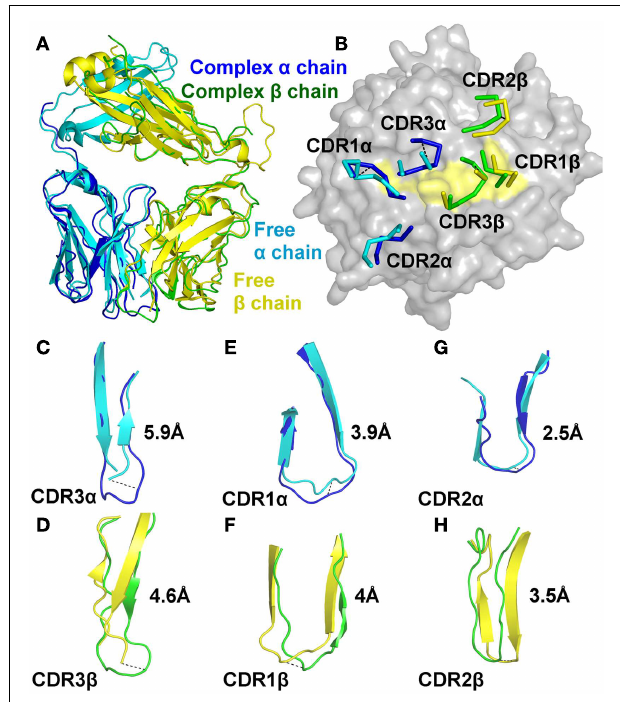
FIGURE 2 |TheA6c134TCR CDR loops undergo a large degree of conformational adjustment during binding toA2-Tax . Comparison of the conformations of the A6c134TCR CDR1, CDR2, and CDR3 loops in the A6c134/A2-Tax complex versus A6c134TCR free structures. (A) Superposition of the free (cyan and yellow cartoon) and complexed (blue and green cartoon) A6c134TCR. (B) Superposition of the free (cyan and yellow lines) and complexed (blue and green lines) A6c134TCR looking down on the A2-Tax surface (gray and yellow surface). (C) Superposition of the free (cyan cartoon) and complexed (blue cartoon) A6c134TCR CDR3 α loop. (D) Superposition of the free (yellow cartoon) and complexed (green cartoon) A6c134TCR CDR3 β loop. (E) Superposition of the free (cyan cartoon) and complexed (blue cartoon) A6c134TCR CDR1 α loop. (F) Superposition of the free (yellow cartoon) and complexed (green cartoon) A6c134TCR CDR1 β loop. (G) Superposition of the free (cyan cartoon) and complexed (blue cartoon) A6c134TCR CDR2 α loop. (H) Superposition of the free (yellow cartoon) and complexed (green cartoon) A6c134TCR CDR2 β loop. Loop moments at the apex, or region of greatest movement are shown.